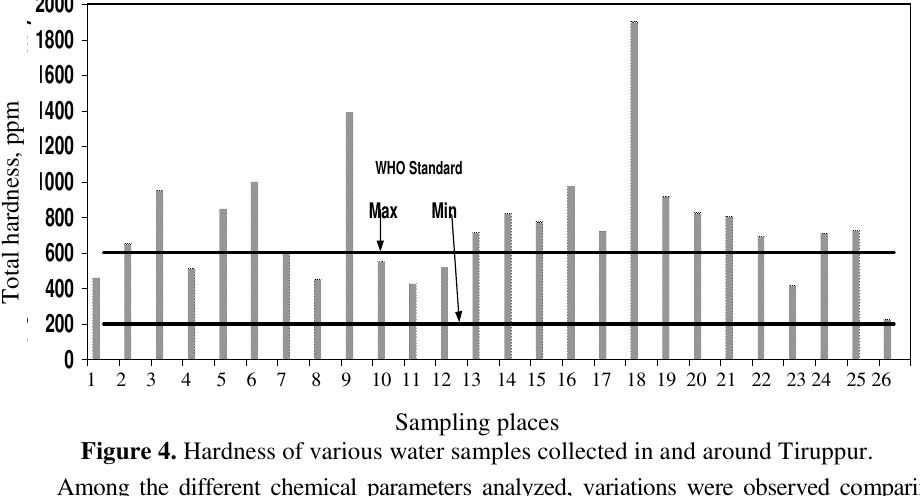
Figure 4. Hardness of various water samples collected in and around Tiruppur.